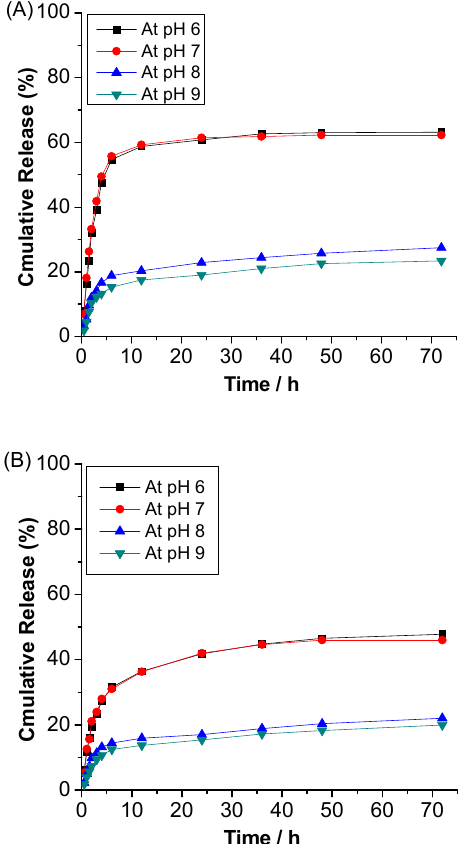
Figure 6. Drug release profiles of Doxy loaded in: ( A ) PTBAEMA-b-POEGMA-MSNs (without amine in inner surface) and ( B ) PTBAEMA-b-POEGMA-MSNs (with amine in inner surface) nanocarriers in mild acidic (6.0), neutral (7.0), and basic (8.0 and 9.0) pH conditions at room temperature.